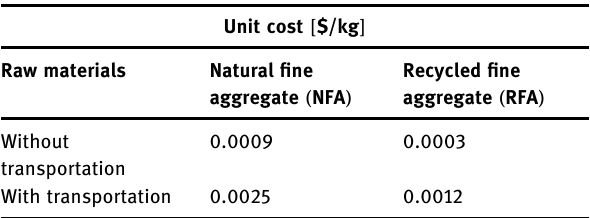
Table 2: The estimated unit cost of the fi ne aggregates used in the epoxy resin coating with RFA ( $/kg )